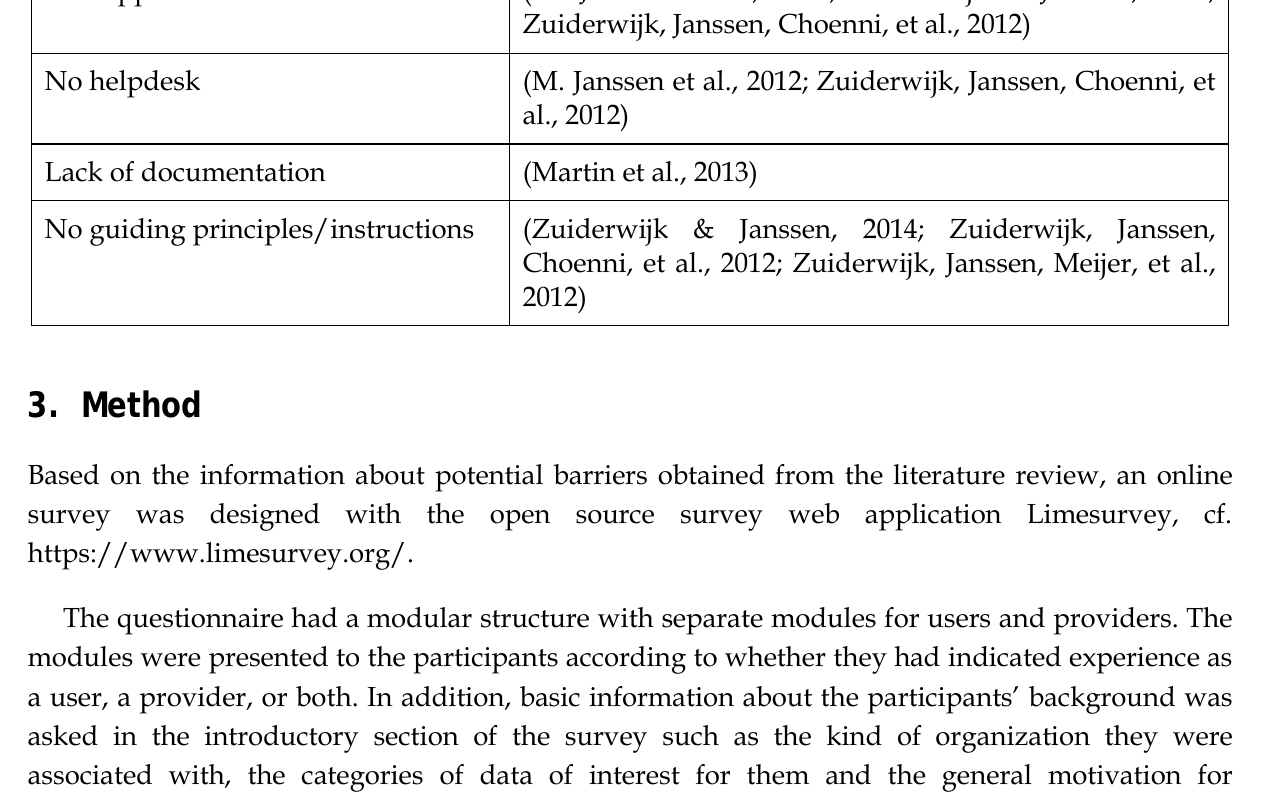
Table 8: Knowledge and Experience (Source: Authors)